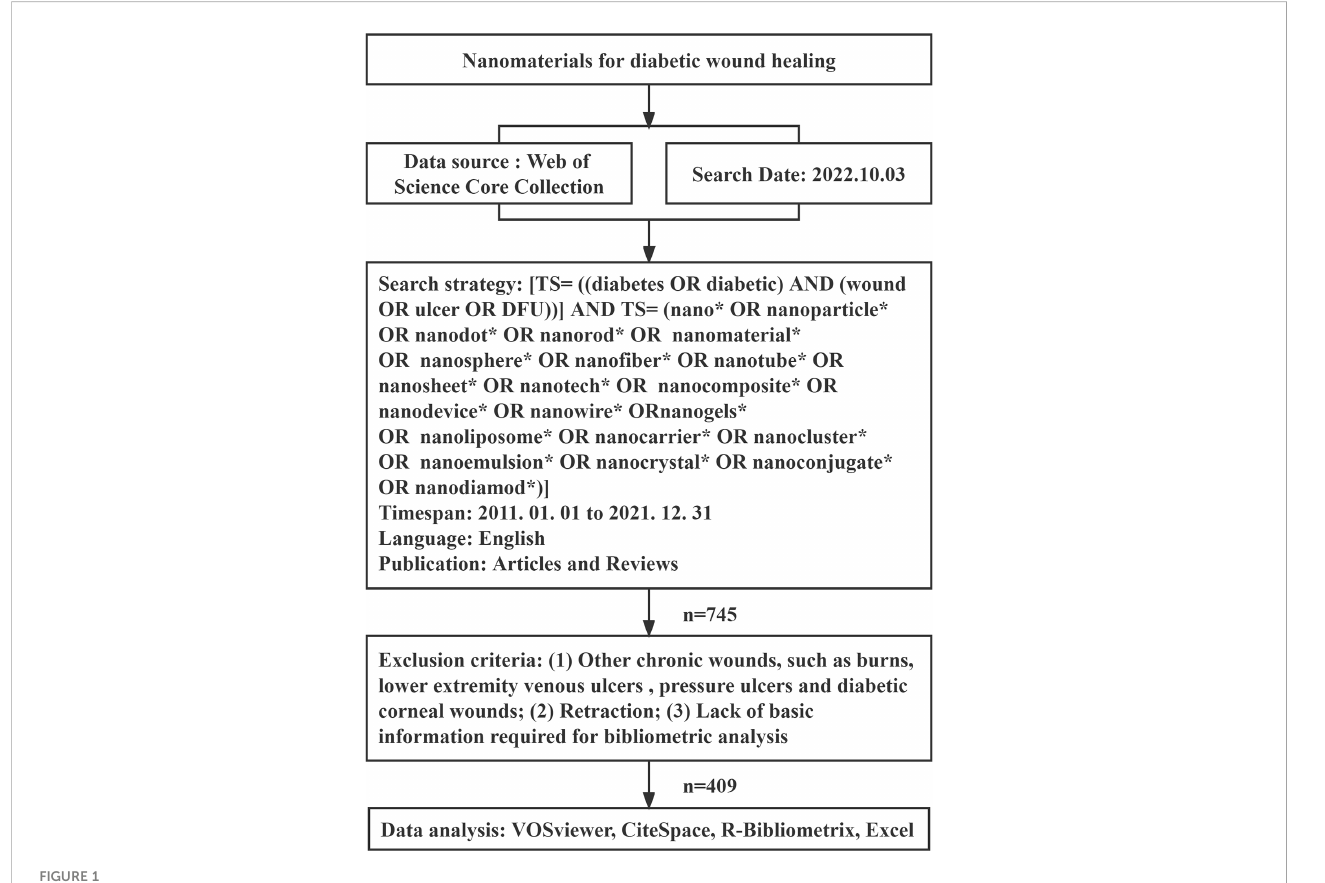
FIGURE 1 Flowchart for including and excluding publications.